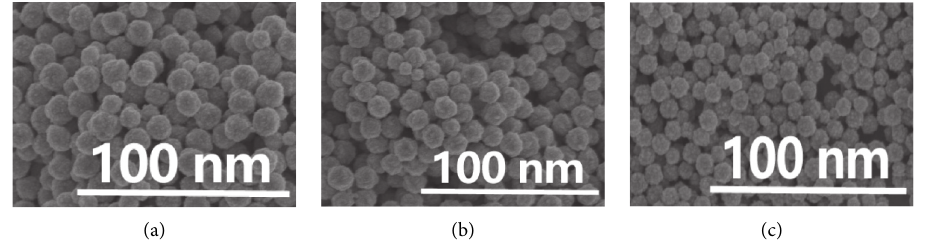
Figure 1: Low-power SEM images of product of Ag + /Au III at different molar ratios (a) 10:1; (b) 5:1; (c) 2 :1.